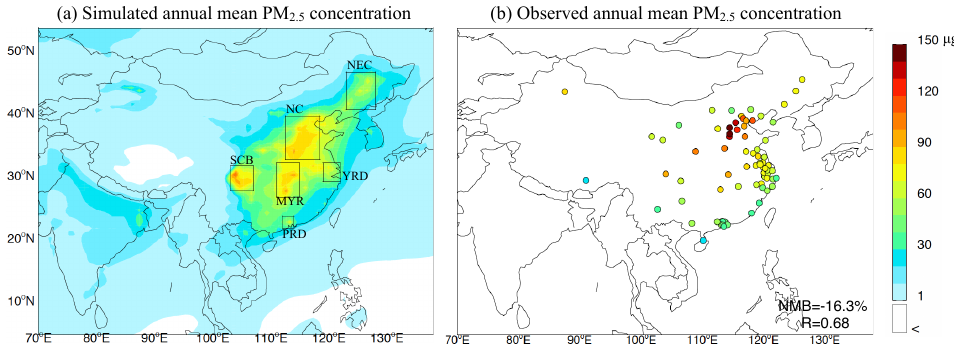
Figure 1. Simulated and observed annual mean PM 2 . 5 concentration in China. The six key regions include the Northeast China (NEC), North China (NC), Yangzte River Delta (YRD), Sichuan Basin (SCB), Middle Yangzte River (MYR), and Pearl River Delta (PRD).